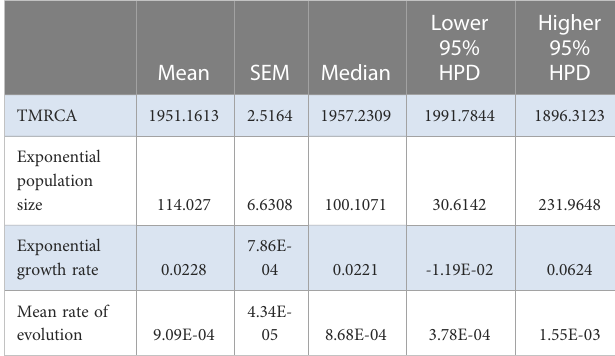
TABLE 1 Relevant estimates from the Bayesian analysis for the Chinese AMV